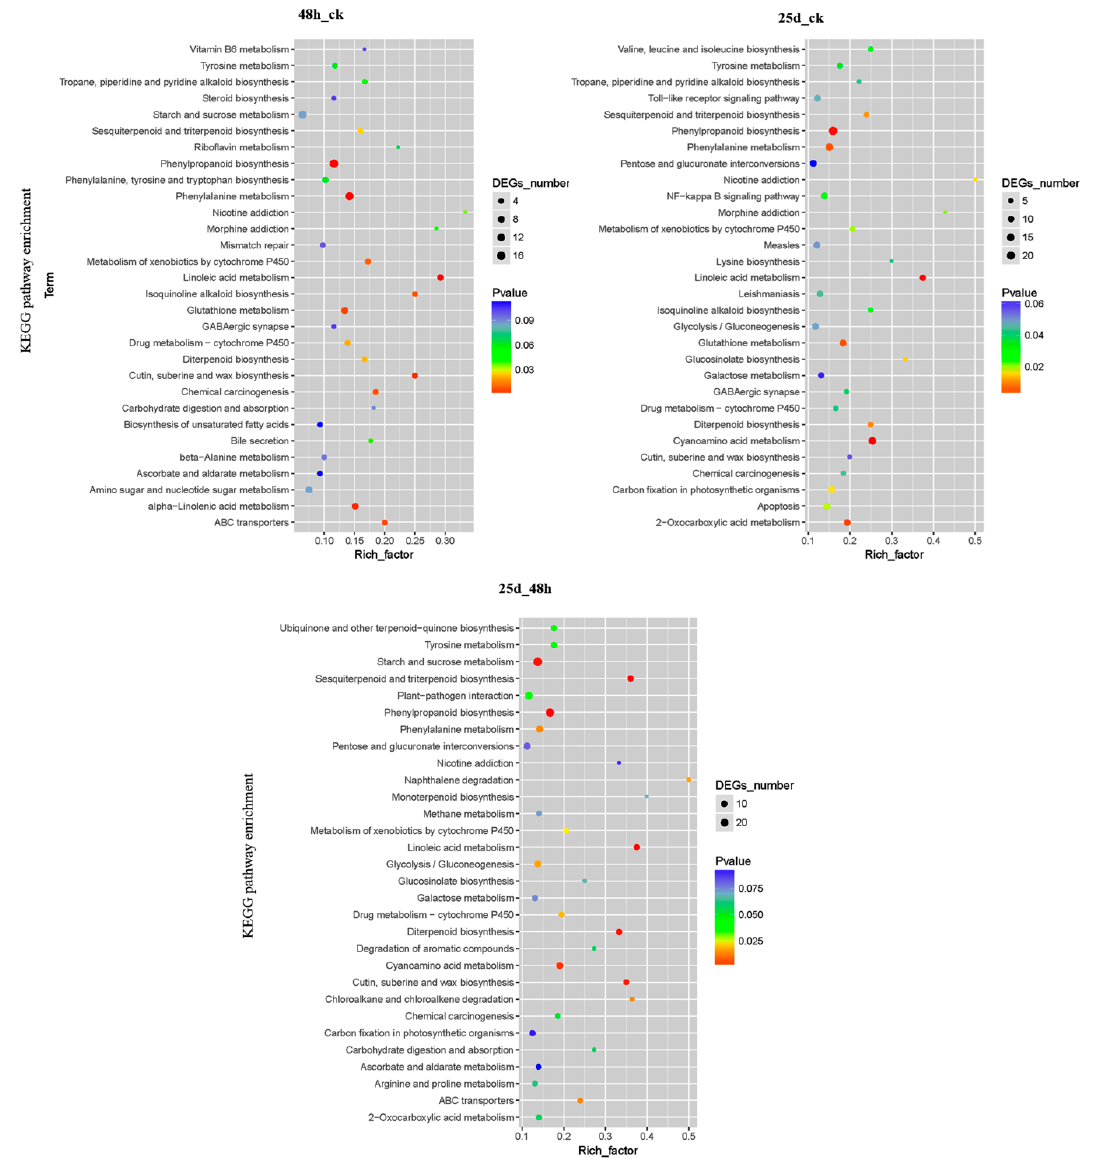
Figure 9. Statistics of the top 20 pathways enriched for DMGs in 48h_ck, 25d_ck, and 25d_48h. The size of each circle represents the number of DMGs enriched in the corresponding pathway. The enrichment factor was calculated using the number of enriched genes divided by the total number of background genes in the corresponding pathway. The p -value was calculated using the Benjamini–Hochberg correction. A pathway with p < 0.05 was considered significantly enriched.